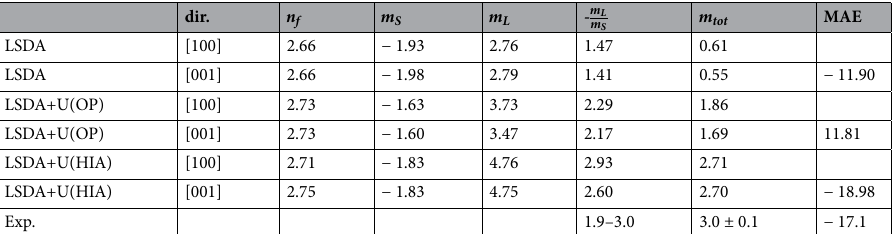
Table 1. UGa 2 —the occupation of the 5f shell n f , the spin and orbital magnetic moments in the uranium atom 5f shell, m S and m L (in µ B ), their ratio − m L / m S , the total magnetic moment in the unit cell m tot (in µ B ), and the magnetic anisotropy energy MAE (in meV) in comparison with experimental data. The results of LSDA, LSDA+U(OP), and LSDA+U(HIA) for the magnetization constrained along [100] and [001] crystal directions are